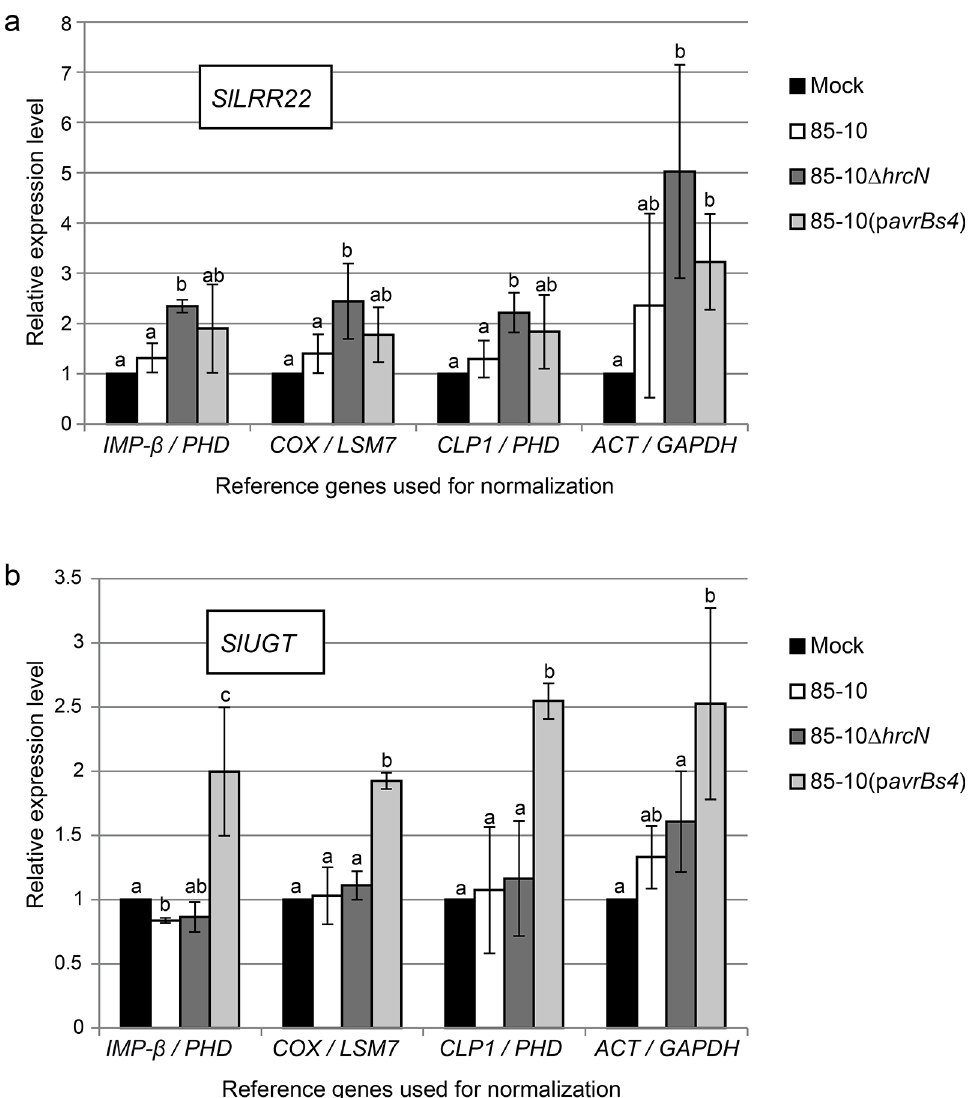
Fig 5. Relative expression of PTI and ETI marker genes in Xcv -infected and mock-treated tomato plants. Expression patterns of SlLRR22 (a) and SlUGT (b) in S . lycopersicum cv. MM leaves treated with 10 mM MgCl 2 (mock) or 5×10 8 cfu/ml of Xcv 85 – 10, 85 – 10 Δ hrcN and 85-10(p avrBs4 ), respectively, 6 hpi. qRT-PCR data were normalized with different reference gene pairs. Values are mean-fold changes in mRNA levels in Xcv -infected relative to mock- inoculated leaves for three biological replicates. Error bars indicate standard deviation (SD). Letters denote statistically significant differences (Student´s t - test, P <